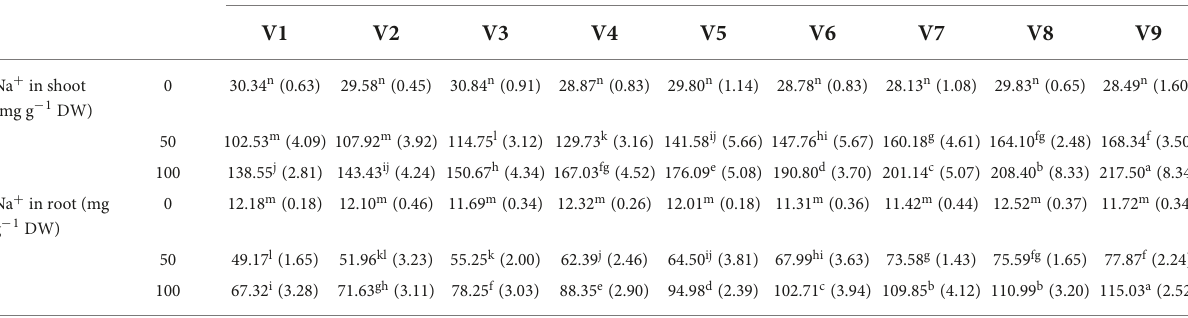
Valuesareexpressedasmeansofthreereplicateswithstandarddeviations. Differentlettersindicatethatvaluesaresignificantlydifferentat p <